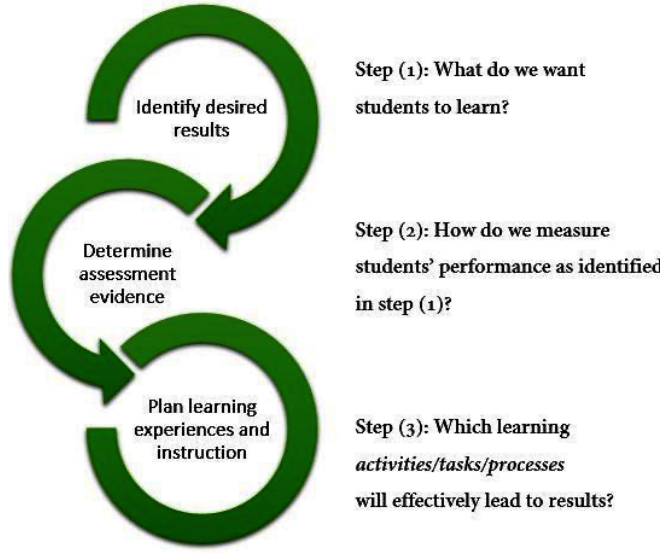
Fig. 3. The Model of Backward Design (Adapted from